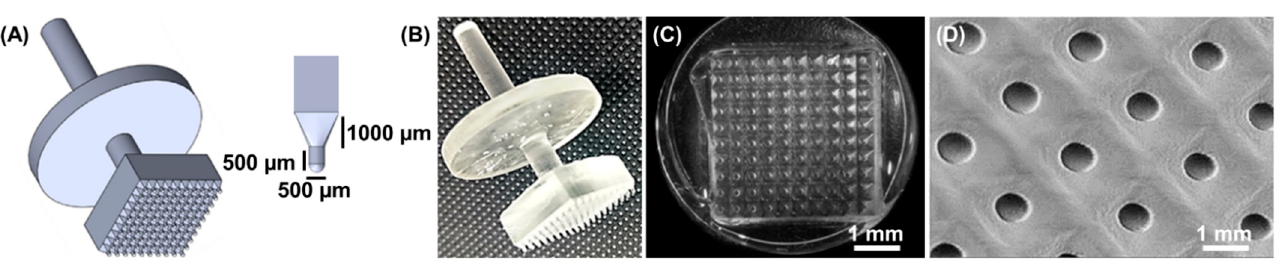
Figure 1. Fabrication of PDMS microwells for microtissue formation. ( A ) Design of the master stamp with negative pattern containing 10 × 10 microwells and the dimensions of the individual microwell. ( B ) 3D printed master stamp. ( C ) PDMS moulds with a 10 × 10 array for microtissue culture. ( D ) Microwells exhibited uniformity in size and shape as confirmed by SEM imaging.